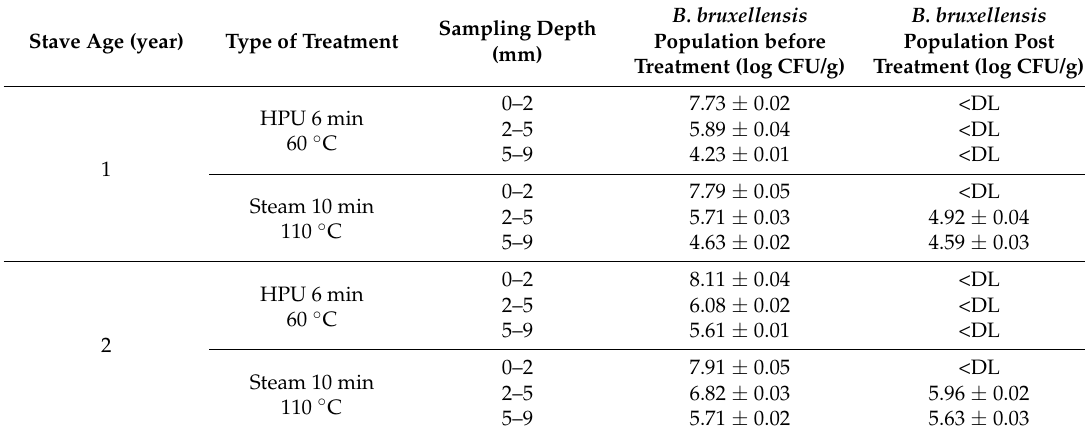
Table 3. B. bruxellensis population before and after HPU or steam treatment on staves of one and two years at different sampling